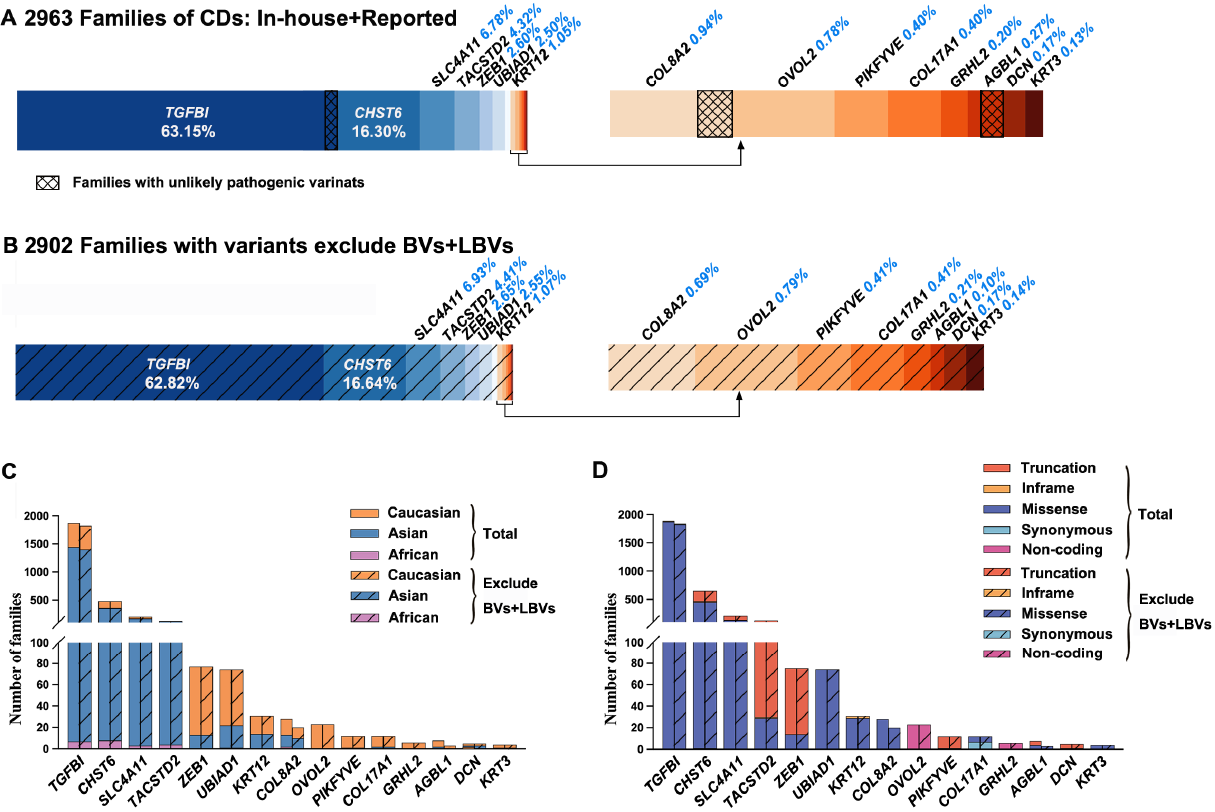
Figure 4. Overview contribution of variants in different genes responsible for CDs and the distribution of variant types as well as ethnic origin of patients. ( A ) Proportion of combined in-house and previously reported families with variants in the 15 genes related to CDs. ( B ) Proportion of families with variants; benign variants (BVs) and likely benign variants (LBVs) in CD-implicated genes were excluded after re-evaluation. ( C ) Distribution of ethnic origin of patients with variants in the 15 genes. The left column indicates total reported variants, while the right column with oblique lines indicates variants with curation after excluding BVs and LBVs. Data included families in current cohort and reported literature reports. ( D ) Distribution of variant types in these genes. The left column indicates total reported variants, while the right column with oblique lines indicates curated variants after excluding BVs and LBVs. Data included families in current cohort and literature reports. Truncation variants include splicing variants, frameshift variants, and nonsense variants.